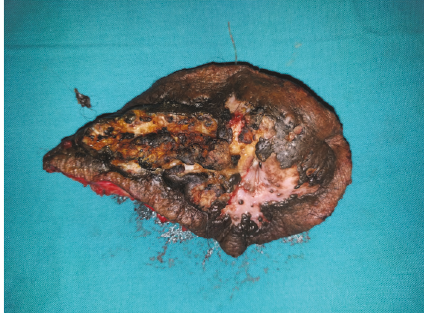
Figure 4: Wide local excision of the growth.